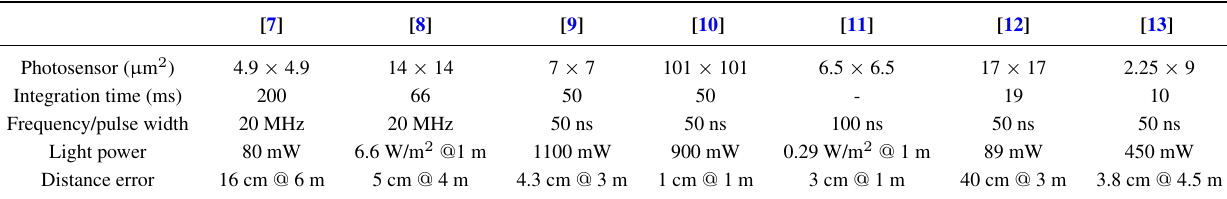
Table 1. Comparison between different experimental results presented in the literature for ToF